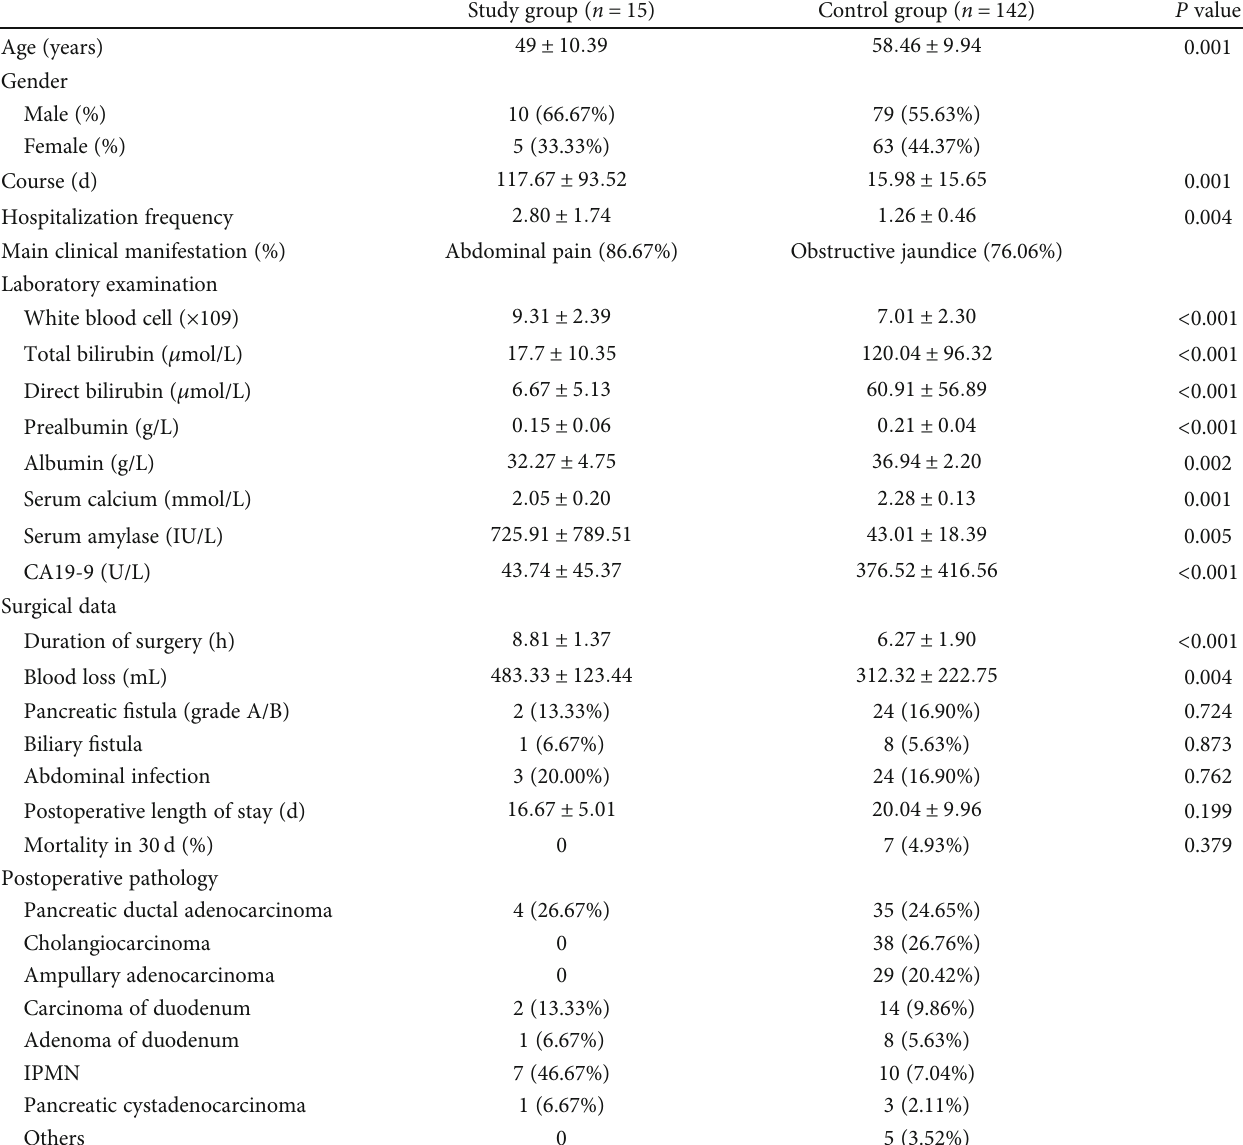
Table 2: Comparison of demographic characteristics and surgical data between